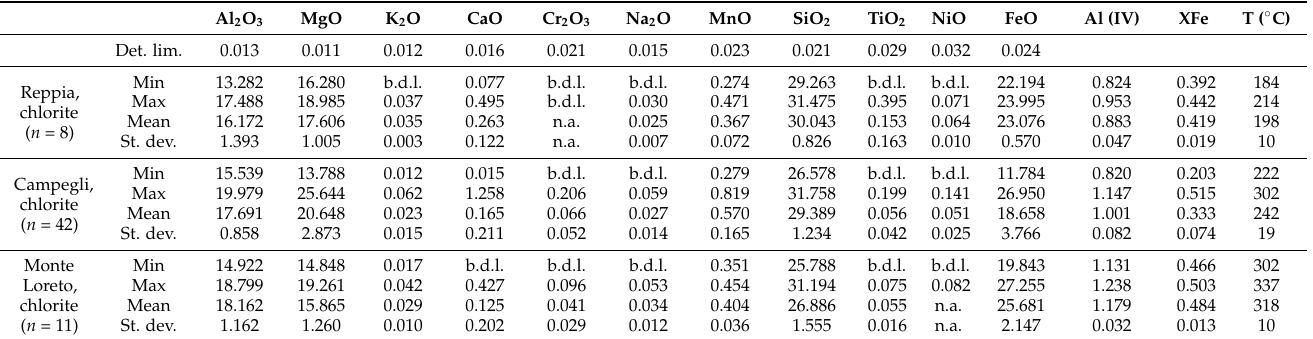
Table 2. Composition of chlorite based on EPMA data in wt.% (Det. lim.—detection limit; St. dev.— standard deviation; b.d.l.—below detection limit; n.a.—not available). Al (IV) and XFe data are based on 14 O. Formation temperature data are based on